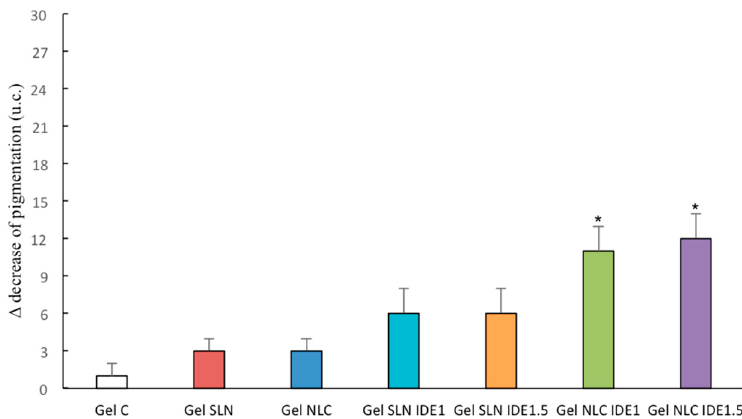
Figure 8. Decrease of skin pigmentation values ( Δ pigmentation) obtained after a two-week in vivo topical treatment with the gels under investigation. Statistical analysis for the comparison: * p < 0.05 vs. Gel C, Gel SLN, Gel NLC, Gel SLN IDE1, and Gel SLN IDE1.5. Gel C = control gel (without lipid nanocarriers), Gel SLN = gel containing unloaded solid lipid nanoparticles (SLN), Gel NLC = gel containing unloaded nanostructured lipid carriers, Gel SLN IDE1 = gel containing idebenone (IDE) 1% w/w loaded SLN, Gel IDE1.5 = gel containing IDE 1.5 % w/w loaded SLN, Gel NLC IDE1 = gel containing NLC loaded with IDE 1% w/w, Gel NLC IDE1.5 = gel containing NLC loaded with IDE 1.5